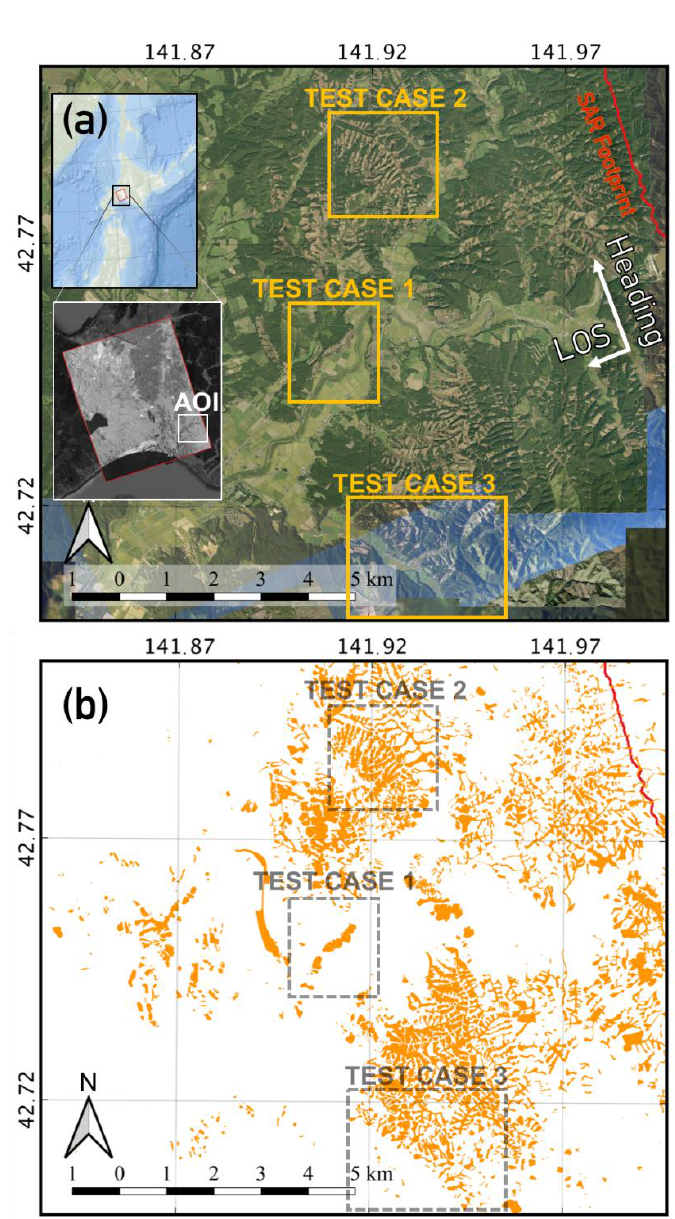
Figure 1. ( a ) Aerial photo acquired over Hokkaido, Japan. Left upper figure shows the geolocation of Hokkaido, Japan and Left middle shows the amplitude of Synthetic Aperture Radar (SAR) imagery and Area of Interest (AOI). Yellow boxes represents three test case areas 1–3. ( b ) Polygons of landslides extracted from aerial photos acquired from Geospatial Information Authority of Japan (GSI). Red polygon represents the boundary of SAR coverage.